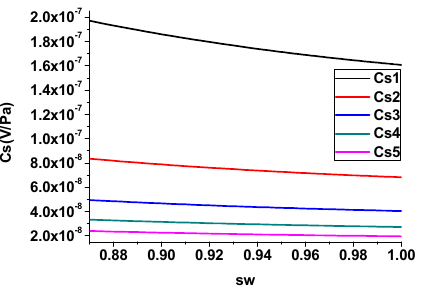
Figure 5. Influence of salinity on streaming potential coupling coefficient (bubbly flow).